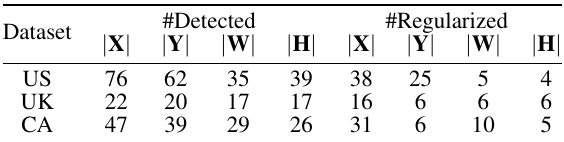
Table 3. Quantitative evaluations of the regularity by the size of the model space before and after regularization, i.e. O a g in Eq. 4. The number of the selected model space significantly reduced after optimization.